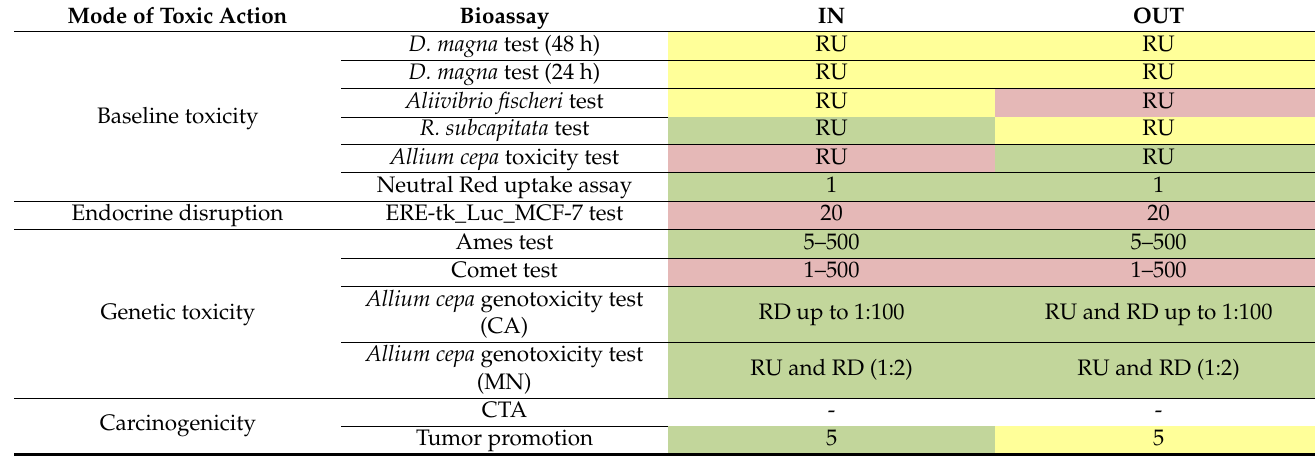
Table 7. “Traffic-light” representation of results for WWTP A. The REF value or type of sample (RU = raw undiluted, RD = raw diluted) used to establish the color of each assay are